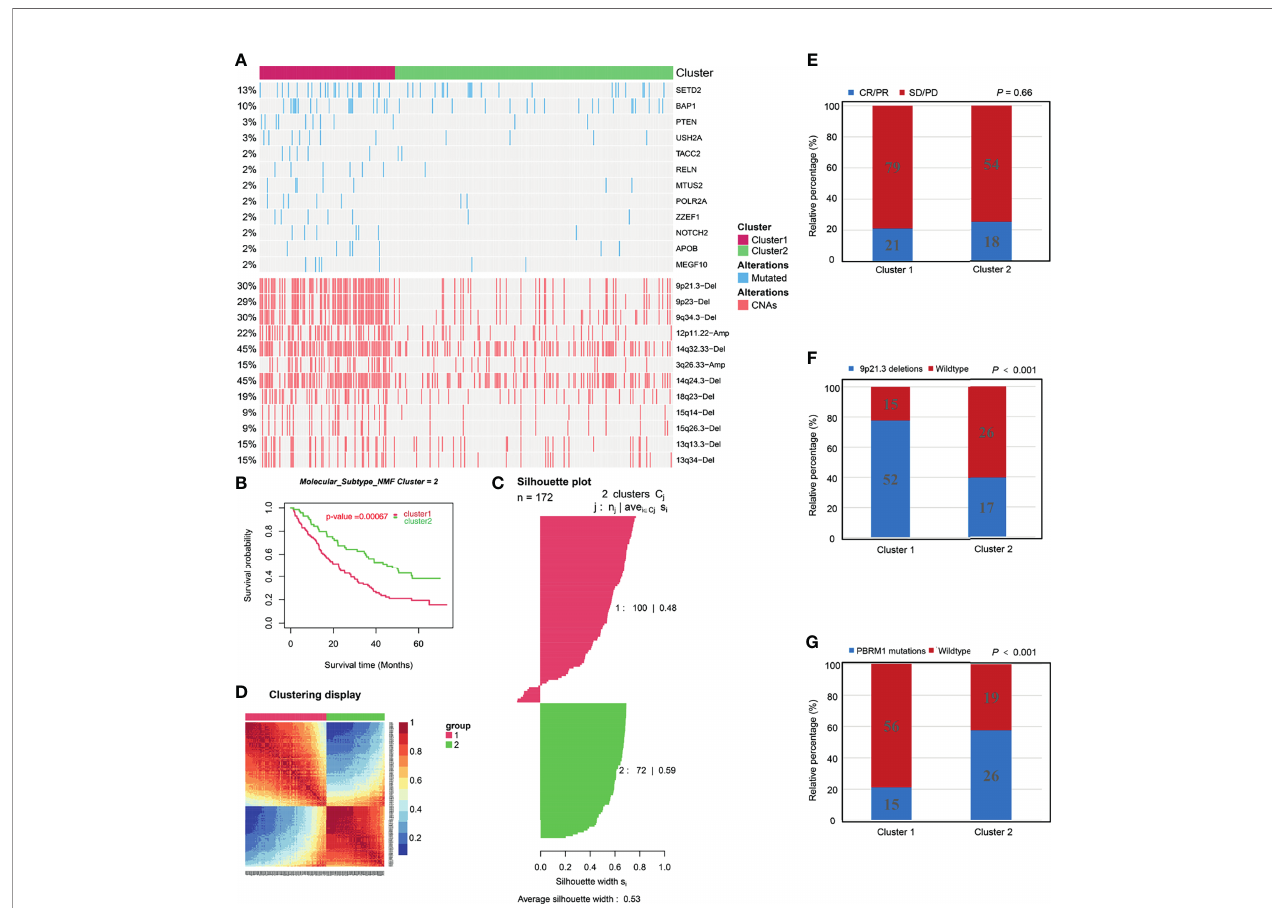
FIGURE 6 | Associations between molecular clusters and immune checkpoint blockade therapy. (A) Distribution of driver genes mutation, copy number alterations (CNAs) among the two molecular clusters. (B-D) Identi fi cation and validation of molecular clusters according to the CD8 + T cell-related genes in the Check-mate 025 cohort. (B) Kaplan-Meier analysis showed the Cluster1 patients had signi fi cantly poorer prognosis than Cluster2 patients. (C) Silhouette coef fi cients indicate that the sample is distinguished from neighboring clusters. (D) Differential expression tested the expression difference between two clusters. (E) The proportion of patients with response to Nivolumab immunotherapy in C1 and C2 cluster. CR, complete response; PR, partial response; SD, stable disease; PD, progressive disease. (F) The proportion of patients with Deletions of 9p21.3 in C1 and C2 cluster. (G) The proportion of patients with PBRM1 mutations in C1 and C2